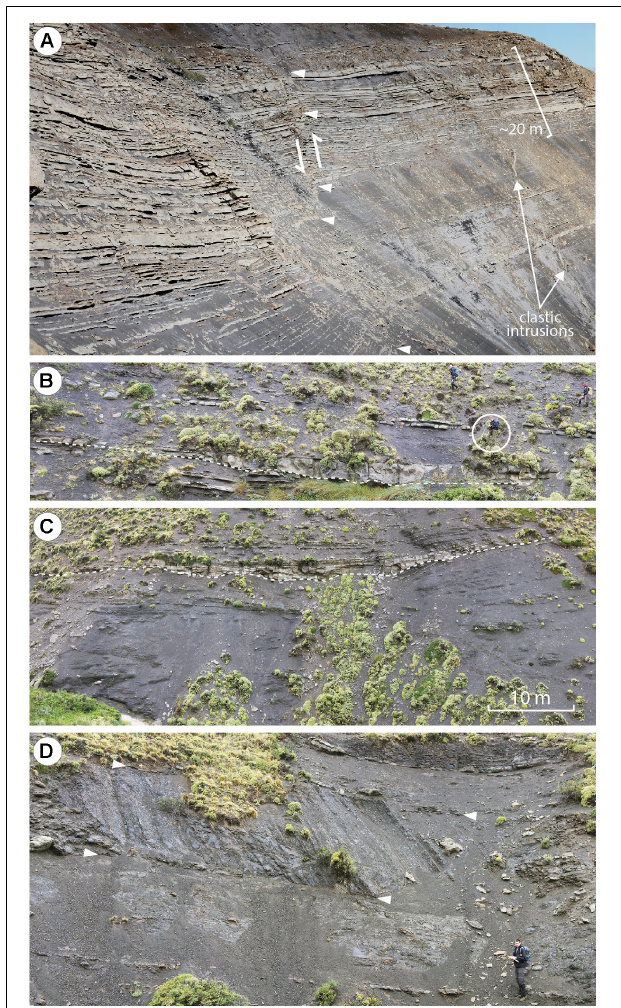
FIGURE 5 | Chingue slope unit stratigraphic architecture and facies. (A) Southward view of El Chingue Bluff (location 5A, Figures 2C , 3 ) characterized by thin and thick bedded non-amalgamated turbidites (F4 and F5) within both the hanging wall and foot wall of a synthetic growth fault (indicated by white arrowheads); clastic intrusions are parallel or sub-parallel to the faults (cf. Shultz and Hubbard, 2005). (B) Interbedded mudstone (F1) and tabular non-amalgamated sandstone (F4), with lenticular scour-fill also present (F5) (base demarcated by thin dashed white line). Note person (circled) for scale. (C) Chaotically bedded fine-grained sandstone and mudstone deposits (F2) overlain by interbedded mudstone (F1) and sandstone (F4 and F5) (separated by white dashed line). The overlying facies are interpreted to have infilled rugose topography on top of the chaotically bedded deposits. (D) Slumped deposits (F2) encased in concordant mudstone (F1). The base and top of the slumped deposits are indicated with white arrowheads. Person at lower right for scale. All outcrop locations are denoted by Figure number within Figures 2C , 3 .